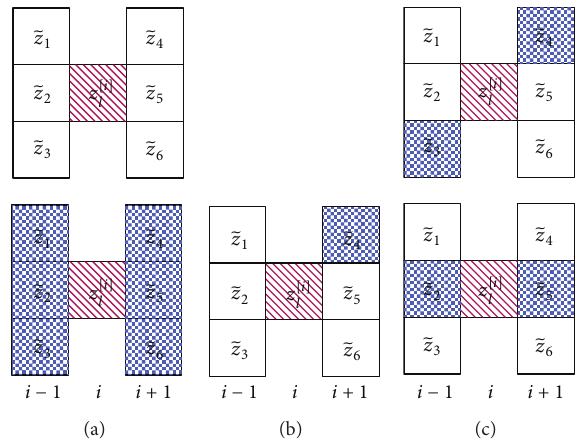
Figure 2: Three patterns for 2D image. White squares denote entries with zeros amplitudes, blue shaded squares denote the entry with nonzero amplitudes, and red shaded squares denote the entry under test. (a) Pattern 1: strong rejection; (b) Pattern 2: examples for weak rejection with 𝜅 [𝑖] 𝑙 = 1 case; (c) Pattern 3: examples for strong acceptance with 𝜒 [𝑖] 𝑙 = 1 case.